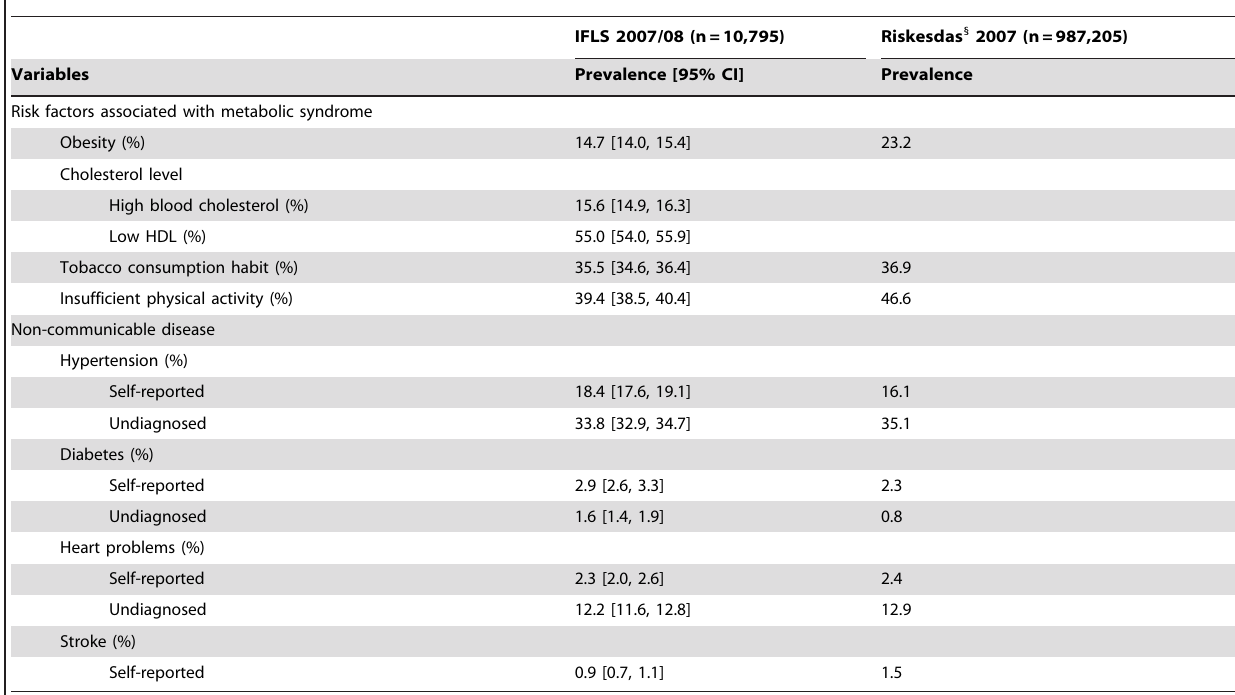
Table 2. Sample prevalence of risk factors and NCDs from IFLS and